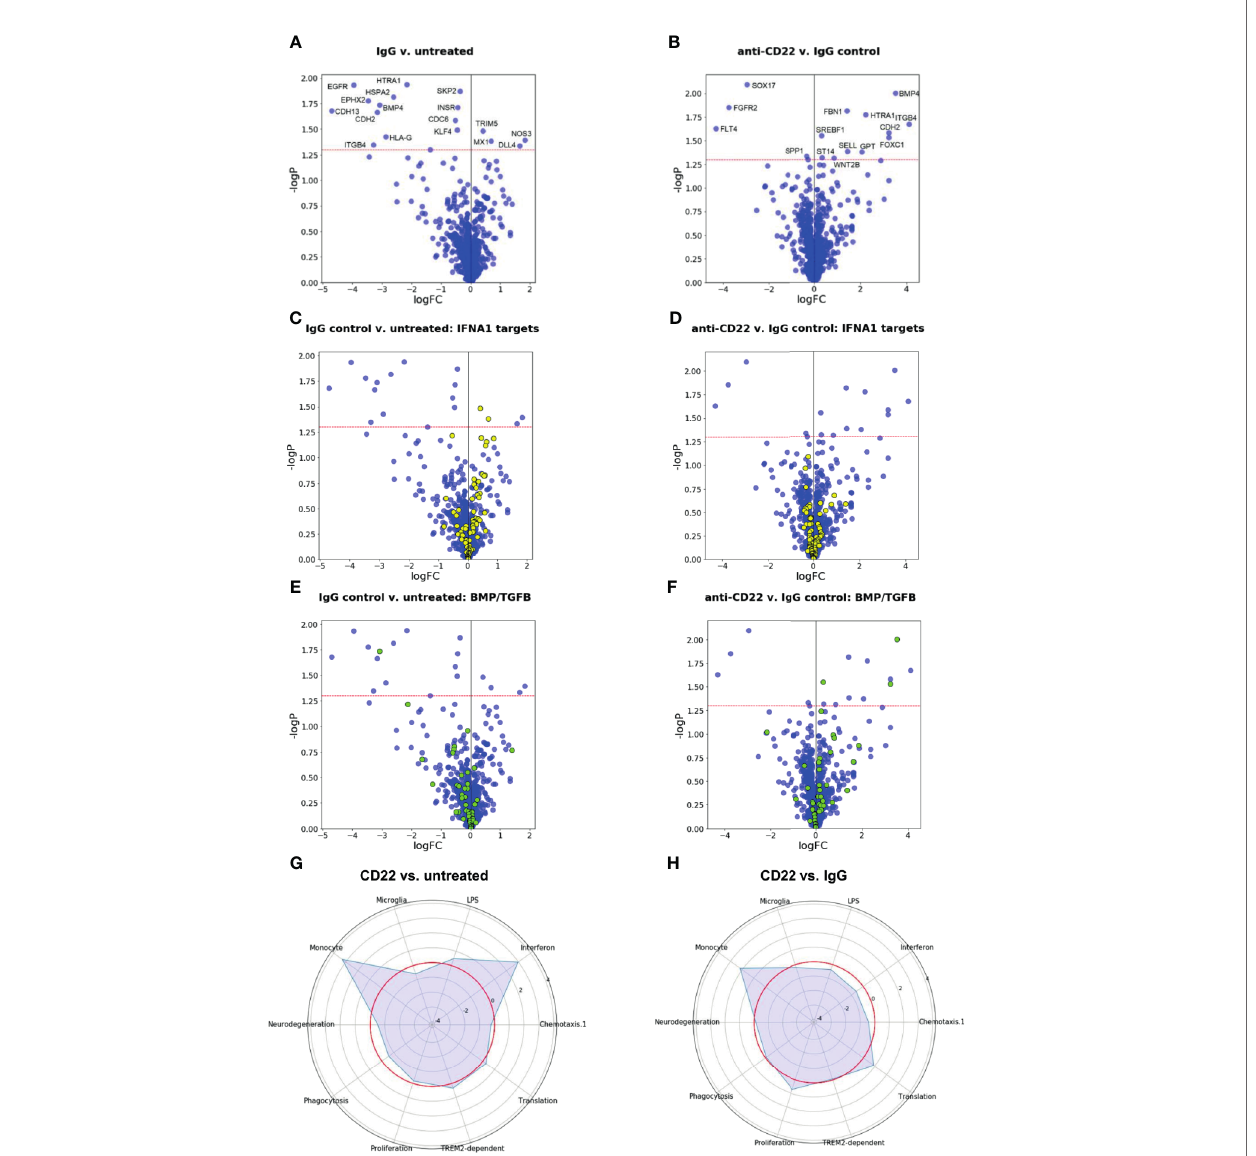
FIGURE 6 | Gene expression and gene set enrichment analyses. (A, B) Volcano plots of treatment effects on gene expression levels in iPSC-derived macrophages. Each point represents one of the 1,062 measured pathway reporter genes. The x axis shows log2 fold changes, the y axis has negative log10 of p values. The red horizontal line indicates a p value cutoff of 5 percent. All genes above the cutoff are indicated by their of fi cial gene symbols. (A) Effects of generic IgG antibody on untreated cells. (B) Effects of anti-CD22 antibody treatment compared to IgG treatment. (C, D) Volcano plots as in (A, B) , with genes annotated as targets of interferon alpha (IFNA) highlighted in yellow. (E, F) Volcano plots as in (A, B) , with genes belonging to BMP/TGFB signaling highlighted in yellow. (G) Radar plot to visualize changes in gene expression in gene modules relevant for microglia induced by CD22 blockage. Plotted values are enrichment scores calculated using CAMERA (32). The red circle indicates the reference level as detected in untreated macrophages. Peaks outside the red circle indicate up-regulation of a module in cells treated with CD22 blocking antibody and modules closer to the center indicate down-regulated modules compared to untreated macrophages. (H) Radar plot to visualize changes in gene expression in microglial modules induced by CD22 blockage in comparison to Isotype treated cells. The red circle indicates the reference level as detected in Isotype treated